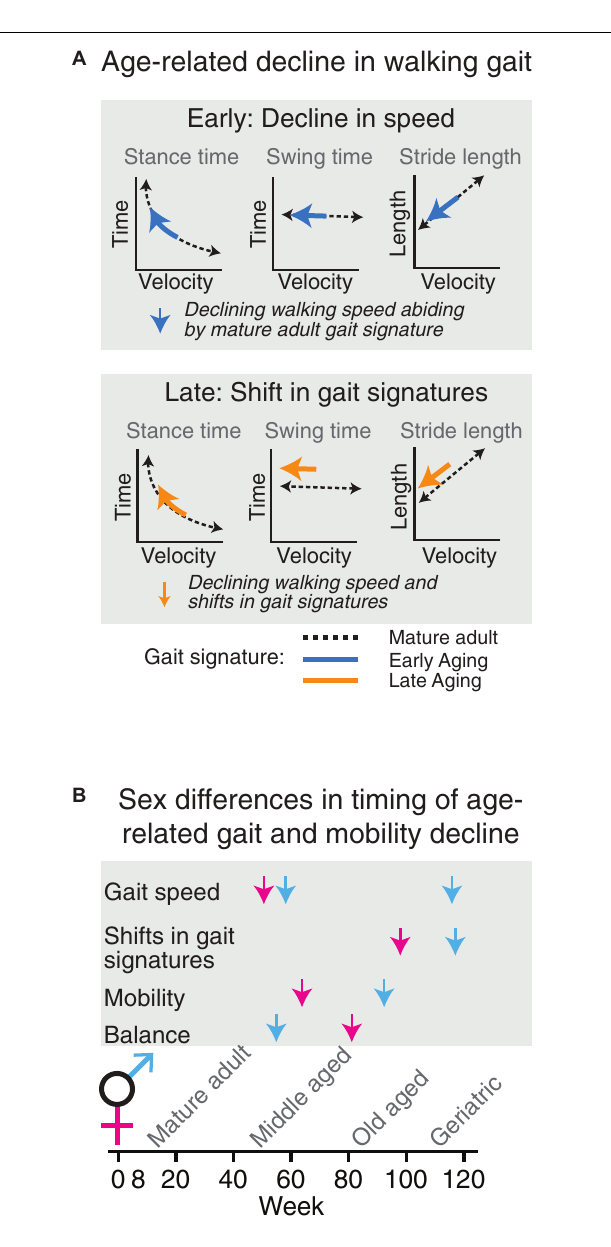
FIGURE 7 | Age-related decline in walking gait occurs in two phases which are temporally dissociated from age-related decline in other measures of mobility. (A) Speed of overground walking decreases early (blue arrows), whereas shifts in gait signatures (orange arrows) signifying a change in gait phenomenology occur at the end stages of the aging process. (B) In aging female (magenta) and male (blue) C57BL/6J mice, changes in gait speed, gait signatures, locomotor activity and balance are temporally